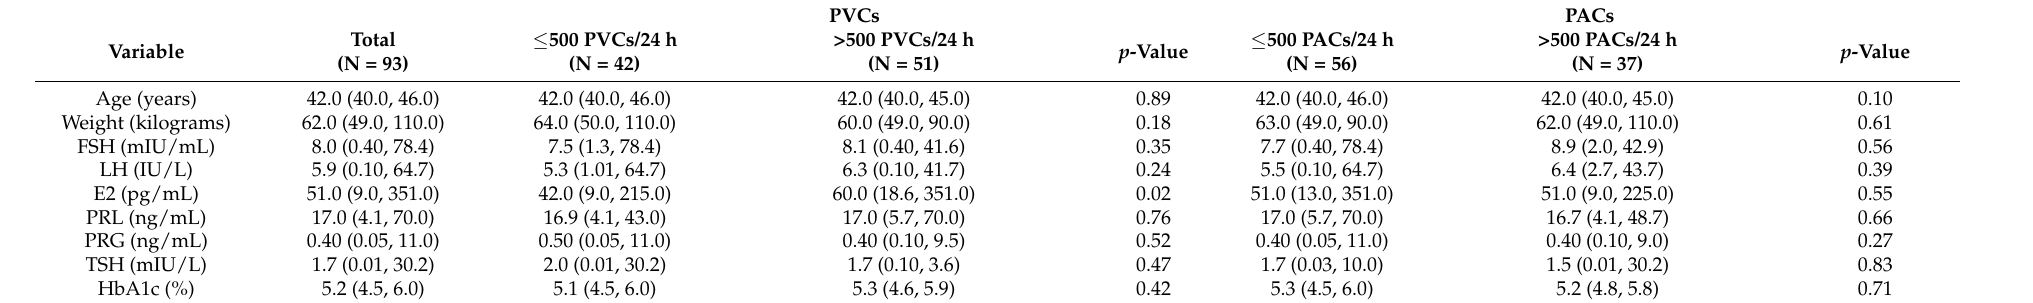
Table 1. Hormone values and patient characteristics by PVC and PAC